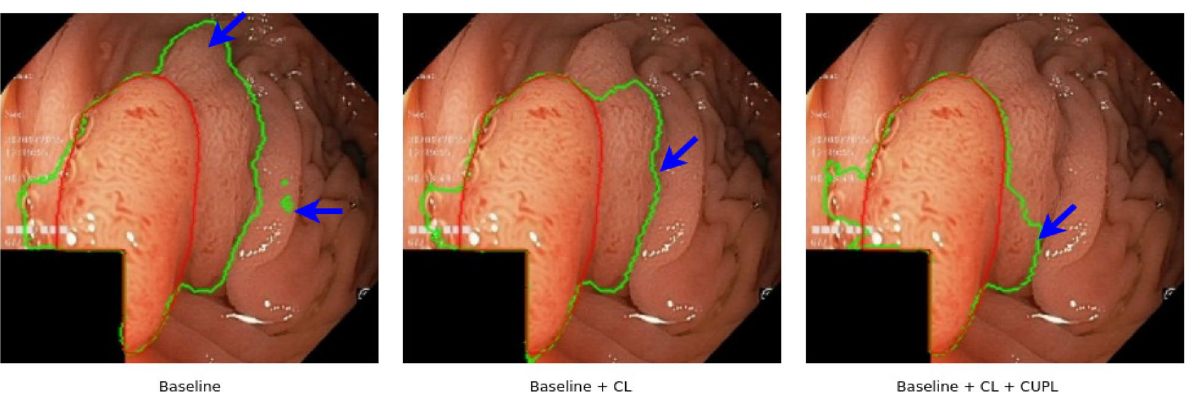
Figure 3. Some pseudo-labels of polyp segmentation obtained by CL and the CUPL on the validation